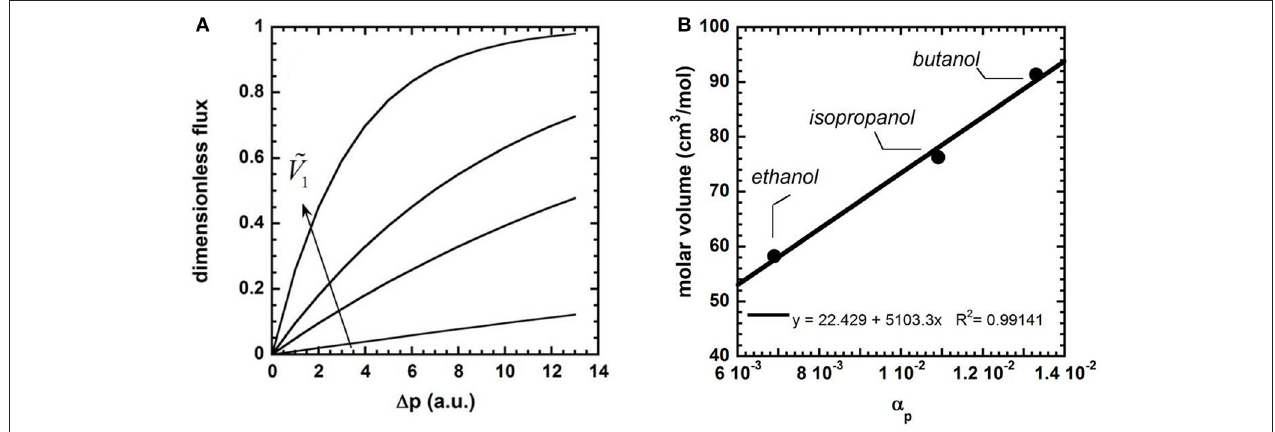
FIGURE 6 | (A) Solvent dimensionless flux vs. 1 p at various solvent molar volumes, as predicted by the Paul theory (Paul, 1973). (B) Solvent molar volume, ˜ V 1 , vs. α p in silicone rubber MPF-50 (Machado et al.,